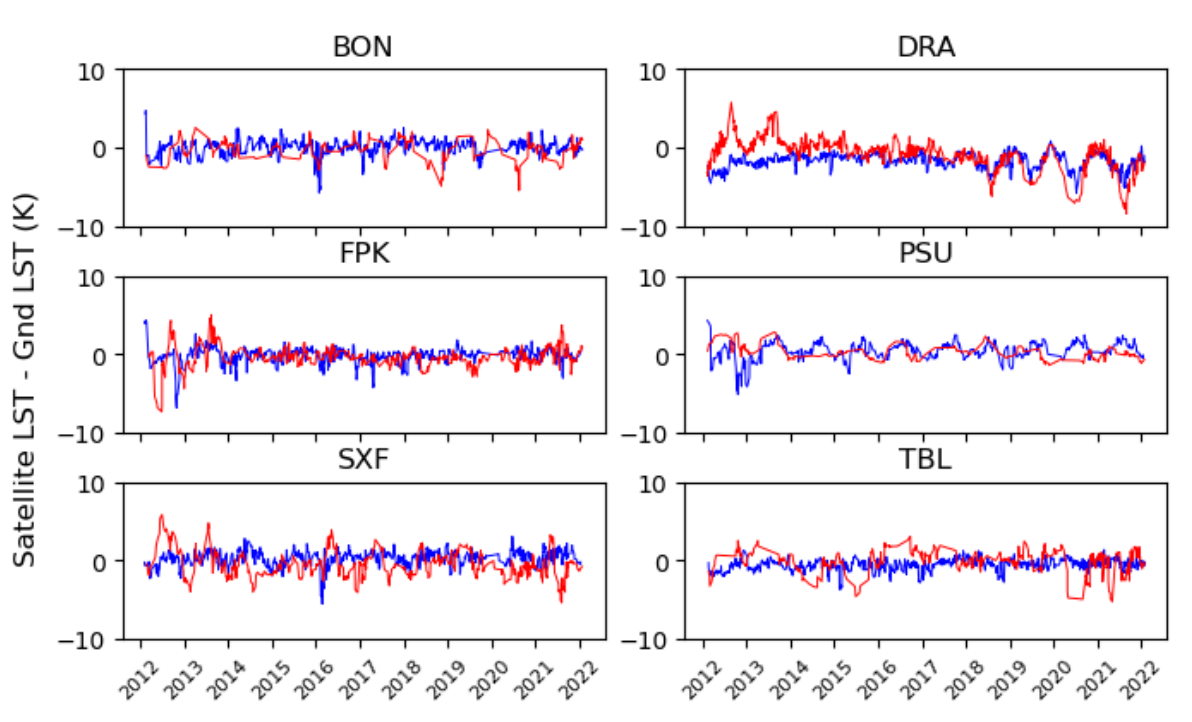
Figure 2. Site-wide validation results for SNPP ( left ) NOAA-20 ( middle ) and VNP21A1 ( right ).